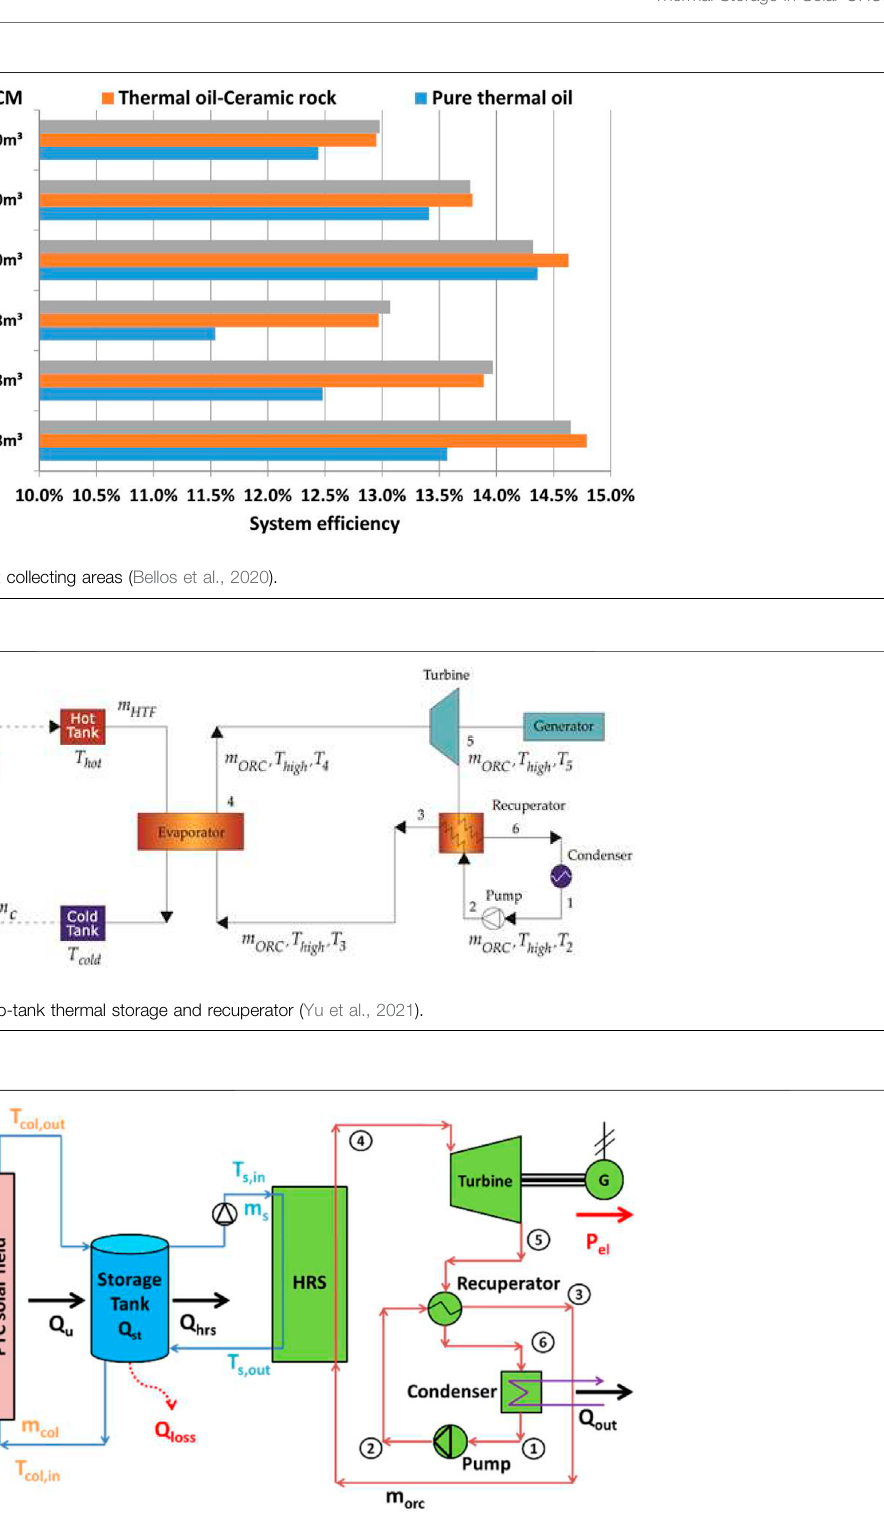
FIGURE 6 | Schematic of solar ORC with storage tank and recuperator (Bellos and Tzivanidis, 2020).